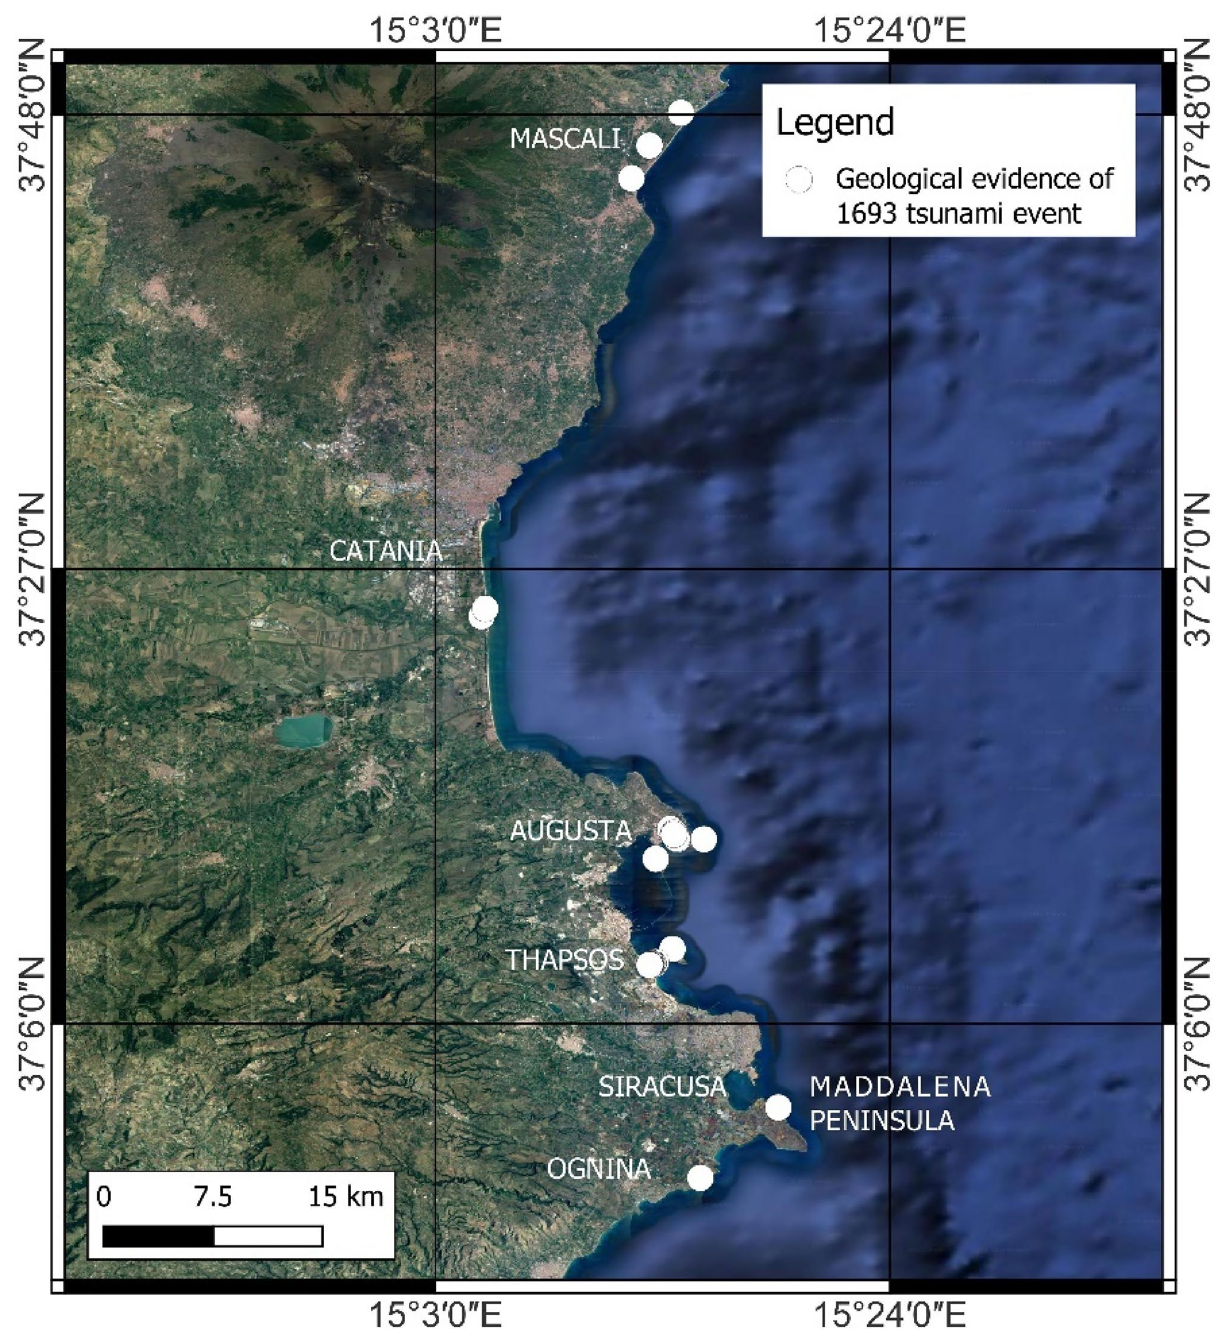
Figure 3. Locations of geological evidence of the 1693 tsunami event along the coast of south-eastern Sicily. The map was obtained by co-authors through QGIS—software (version 3.14.16); https:// www. qgis. org/ it/ site/, license Creative Commons. Attribution-Share Alike 3.0 licence (CC BY-SA) integrated with ESRI World